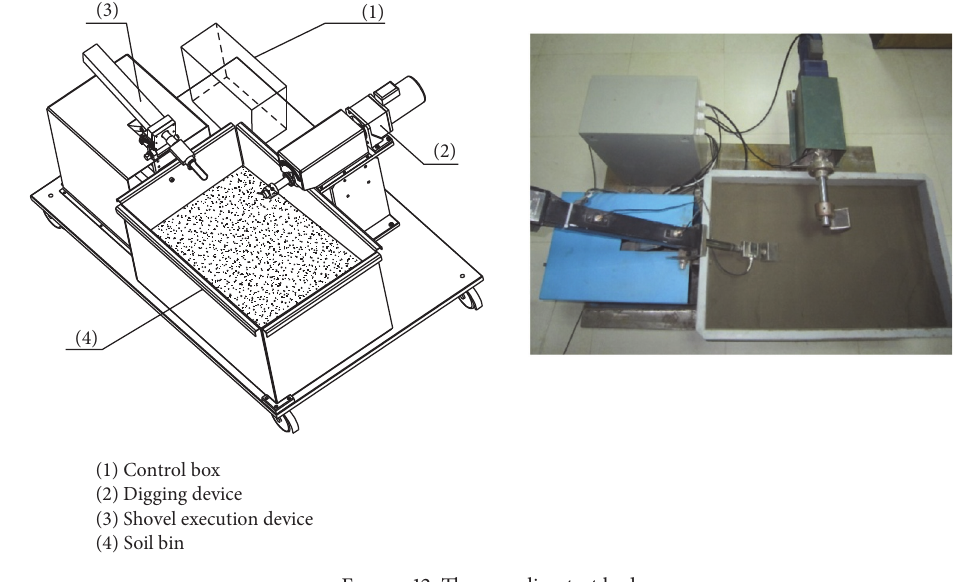
Figure 12: The sampling test bed.